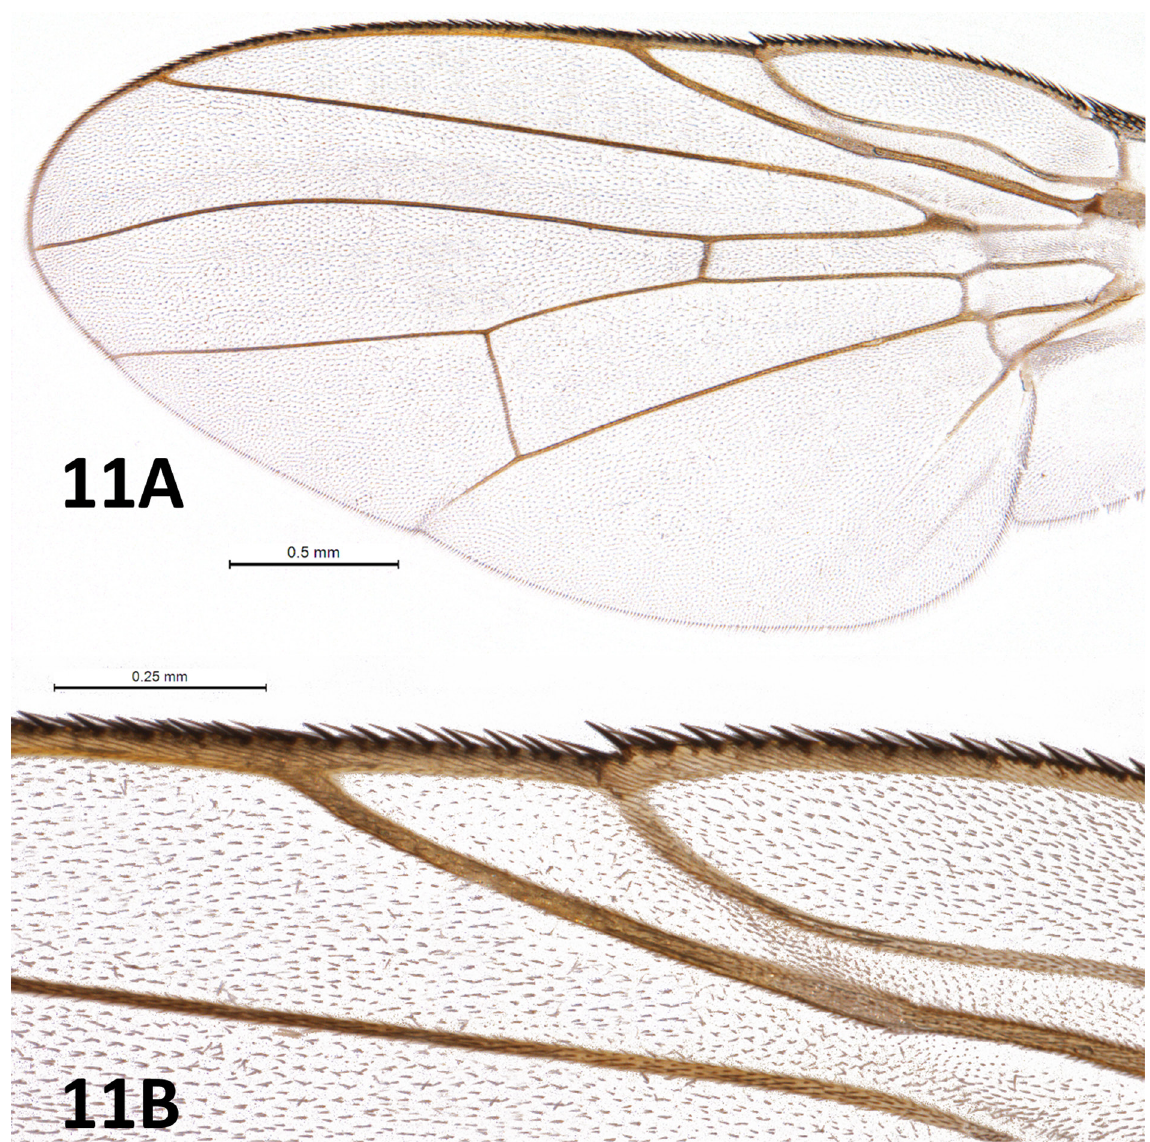
Fig. 11. Atherigona orientalis Schiner, 1868, ♀. A . Wing, ventral view. B . Detail of wing showing CS1‒3, ventral